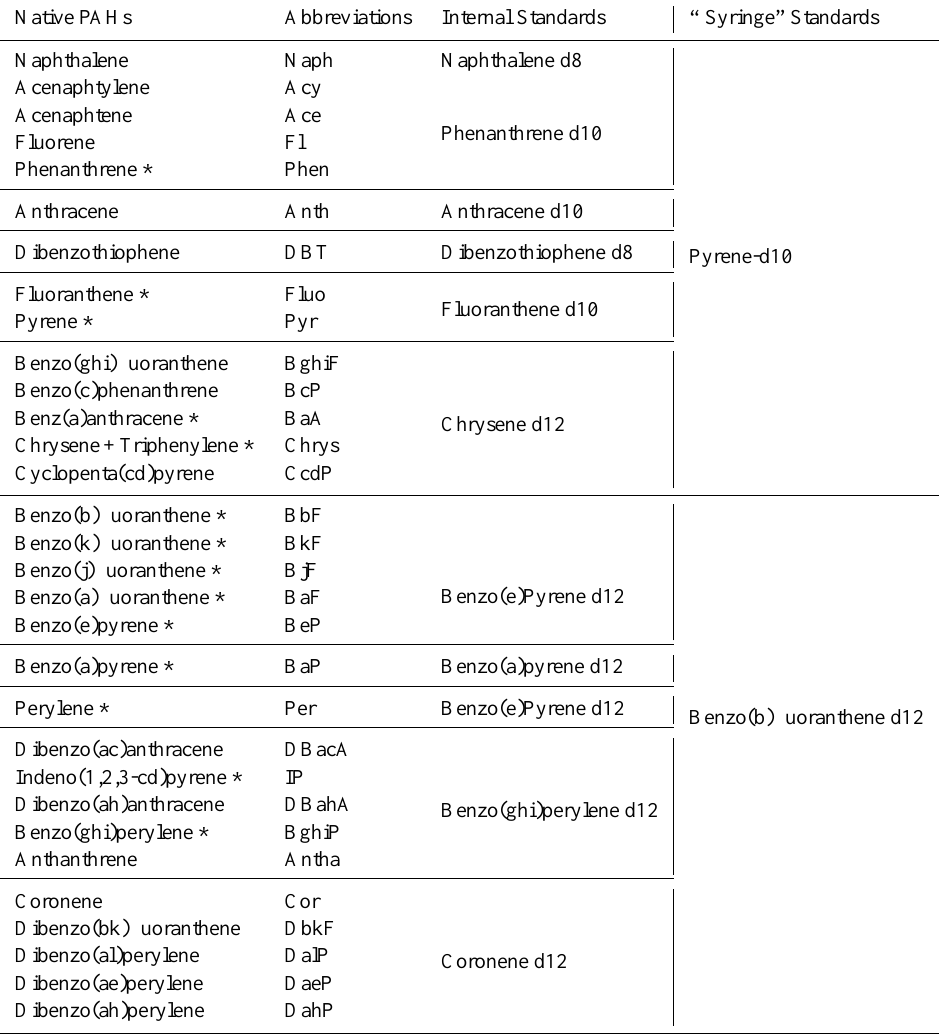
Table 2. List of studied PAHs with the corresponding internal and “syringe” standards. Native PAHs Abbreviations Internal Standards “ Syringe”